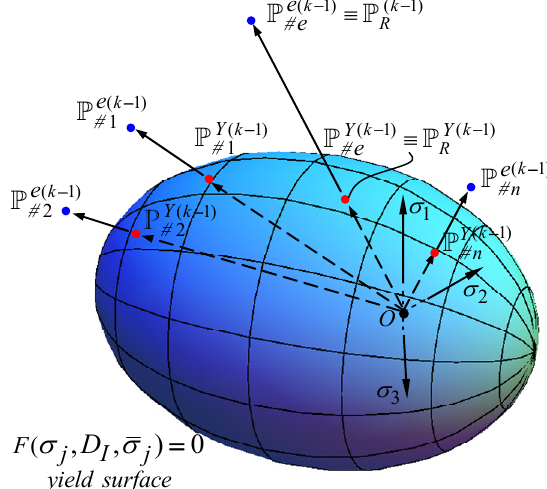
Figure 2: Geometrical sketch, in the principal stress space, of the ECM at current iteration ( k -1) of the current sequence s. Stress points representing the elastic solution at elements #1,#2, ,# , ,# e n   ; with ( 1) k